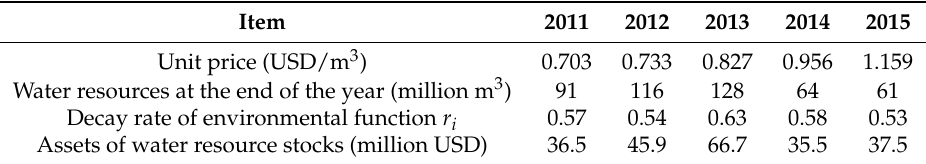
Table 6. Annual assets of water resources in Jinan from 2011 to